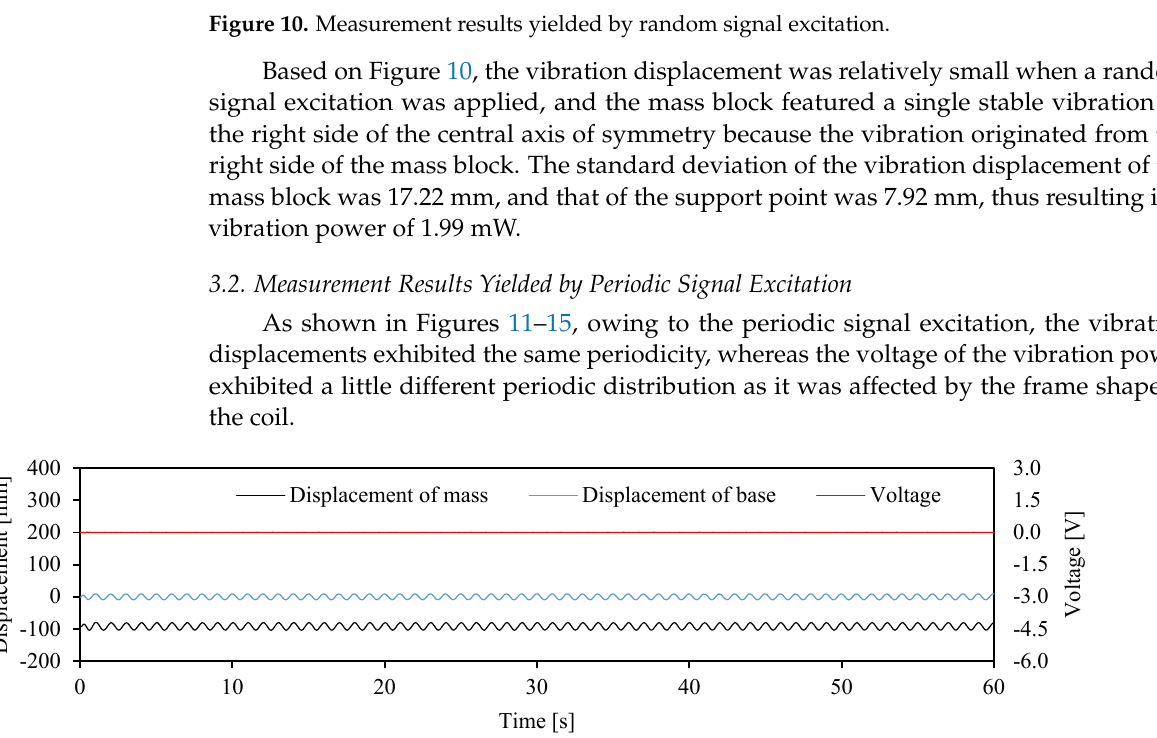
Figure 12. Measurement results for 1.3 Hz periodic signal excitation. The amplitude of the mass block increased further and exceeded that of the support point when the excitation frequency was 1.6 Hz, as shown in Figure 13, which might be because the excitation frequency was similar to the natural frequency of the vibration model. The standard deviations of the vibration displacement of the mass block and sup- port point were 16.87 and 5.71 mm, respectively, which resulted in 1.28 mW of power generated.